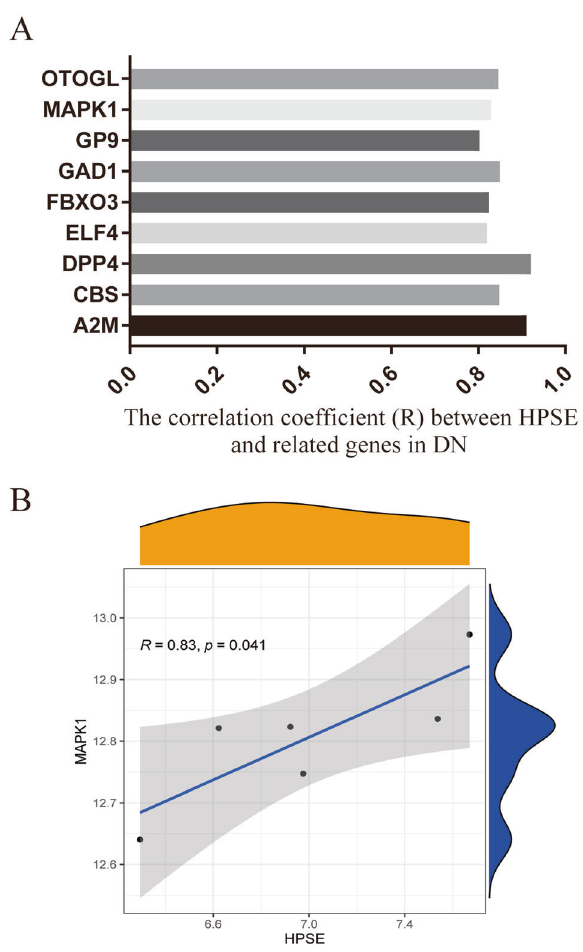
Fig. 3 Bioinformatics analysis revealed a positive correlation between HPSE and ERK. The Pearson correlation analysis of DN patients ’ data ( n = 19) from GEO database (GSE14202) showed that nine related genes ( A ) had a signi fi cant positive correlation with HPSE, including MAPK1 (ERK2) ( B ) ( R = 0.83, P =